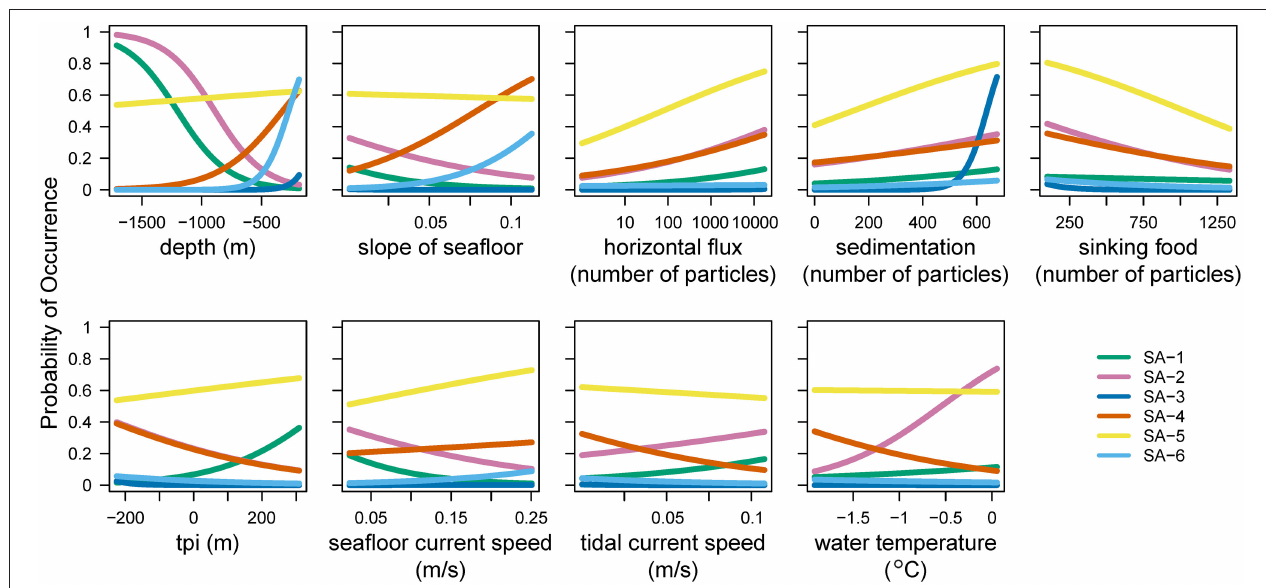
FIGURE 3 | Probability of occurrence for the six species archetypes in relation to each of the environmental variables used in the analysis. A steep slope of a line means that the archetype changes strongly along this environmental gradient, indicating which environmental predictor variables are important in determining the presence or absence of species archetypes. tpi, topographic position